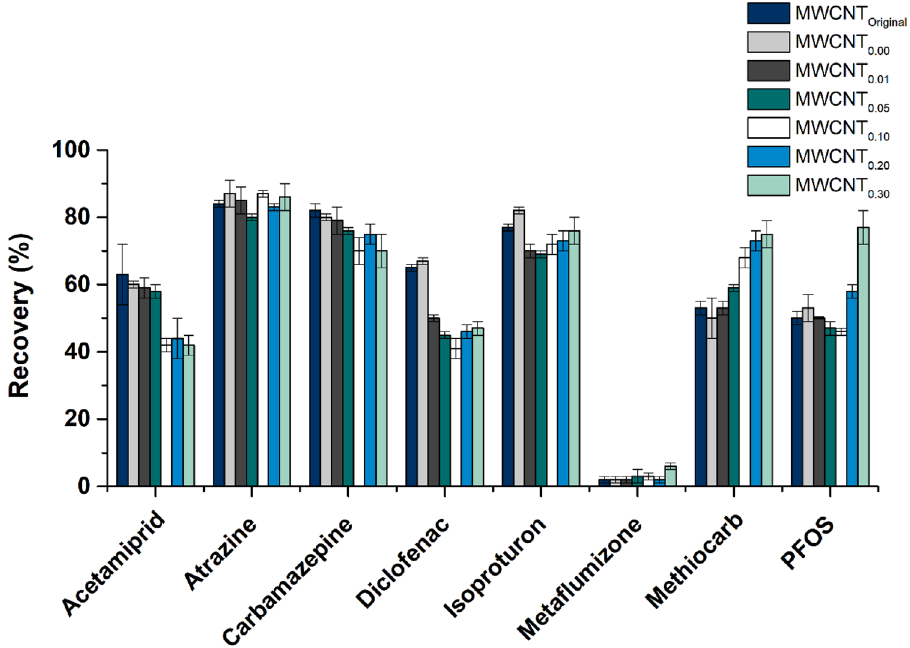
Figure 6. Recoveries obtained for the target micropollutants (200 ng L −1 each), when using cartridges packed with MWCNTs (50 mg) obtained after hydrothermal treatment with different HNO 3 concentrations (0–0.30 mol L −1 ). Experiments performed with 500 mL of sample (SW; pH 3) and using ethanol as solvent (4 mL); n = 3 (RSD is represented as error bars).